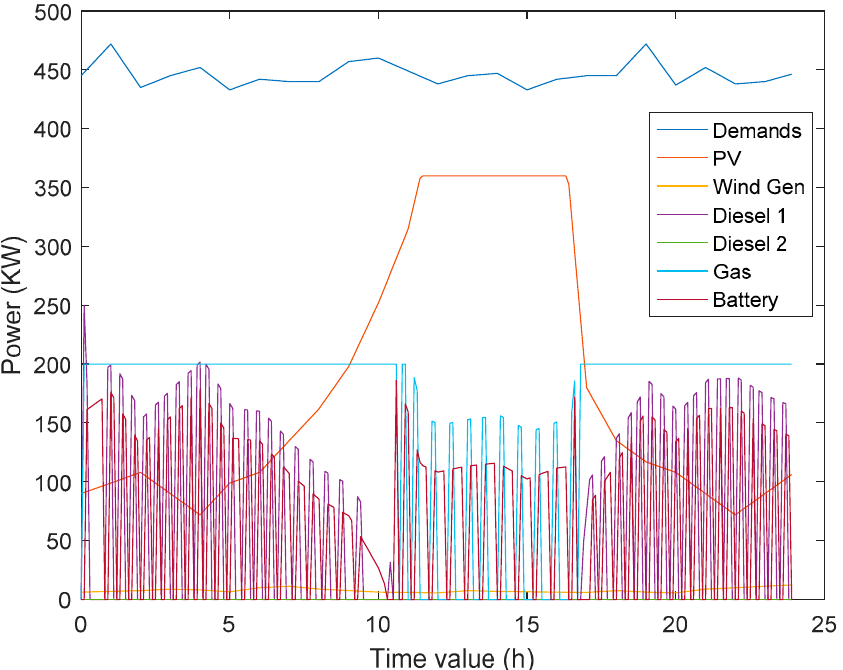
Figure 11. Ship power generation and consumption during Scenario 2. Load Demand (blue), DG1 (purple), LNG (light blue), DG2 (deactivated), PVs (orange), WECs (yellow).